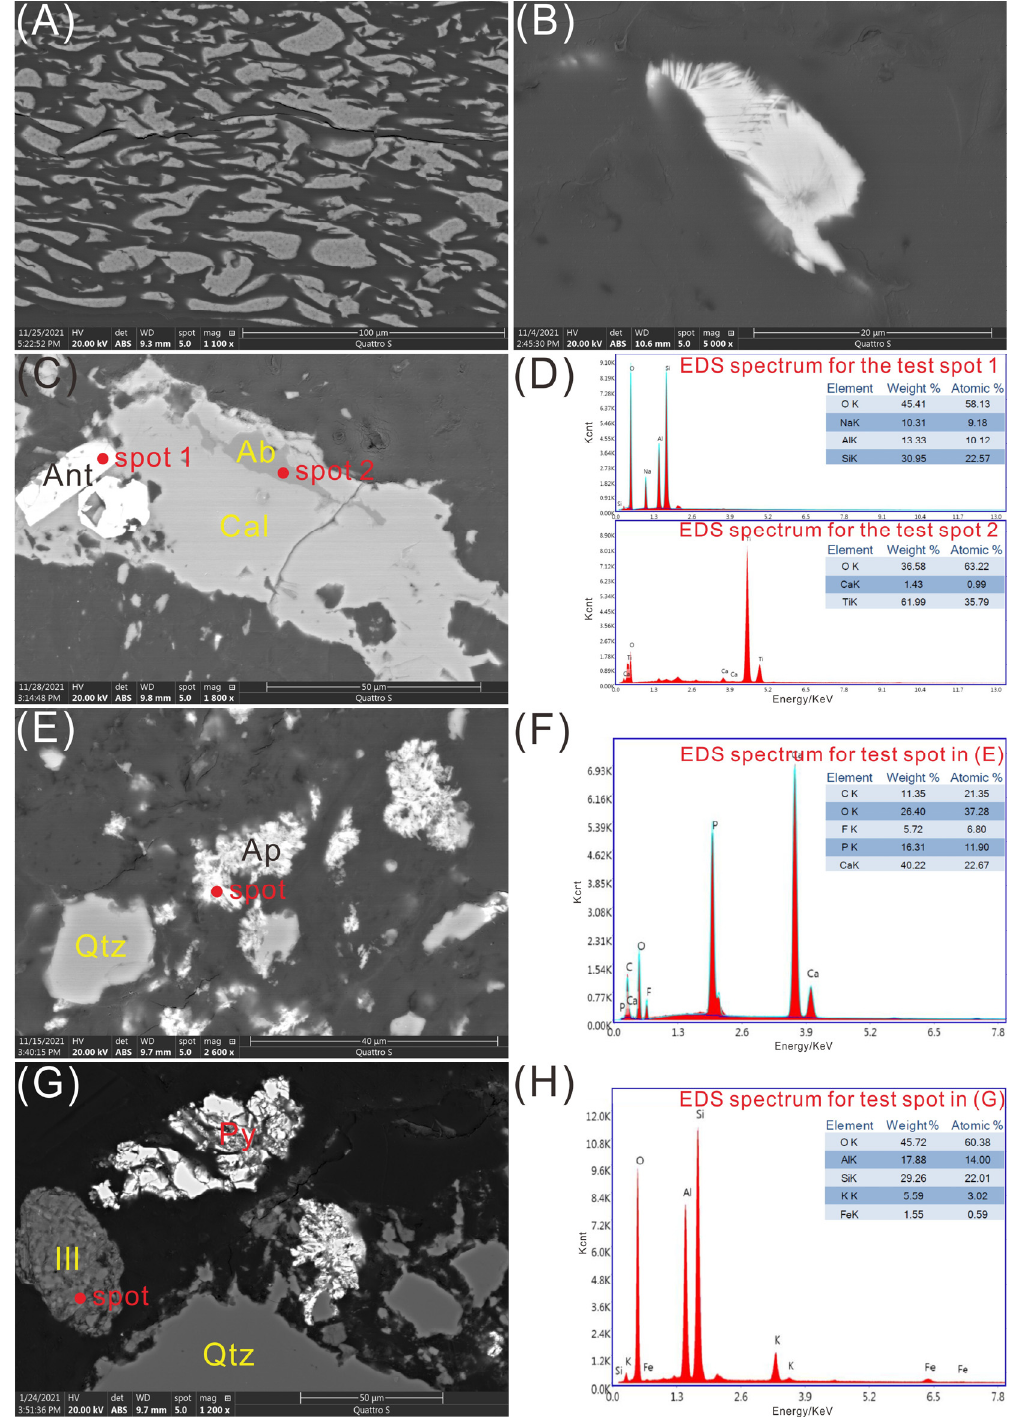
Figure 1. SEM back-scattered electron images of minerals in coal samples: ( A ) kaolinite as cell-fillings in sample TN-10; ( B ) chlorite in sample SB-6; ( C ) anatase, calcite and albite in sample ZT-11; ( D ) EDS data and spectrum for point 1 and 2 in C; ( E ) apatite and quartz in sample SB-6; ( F ) EDS data and spectrum for point in E; ( G ) illite, pyrite and quartz in sample ZT-2; ( H ) EDS data and spectrum for point in G. Ab, albite; Cal, calcite; Ant, anatase; Ap, apatite; Qtz, quartz; Ill, illite; Py, pyrite.